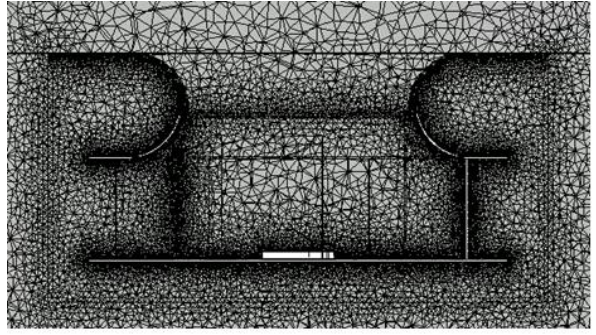
Figure 2. Computational domain. Figure 3. Mesh system. Figure 3. Mesh